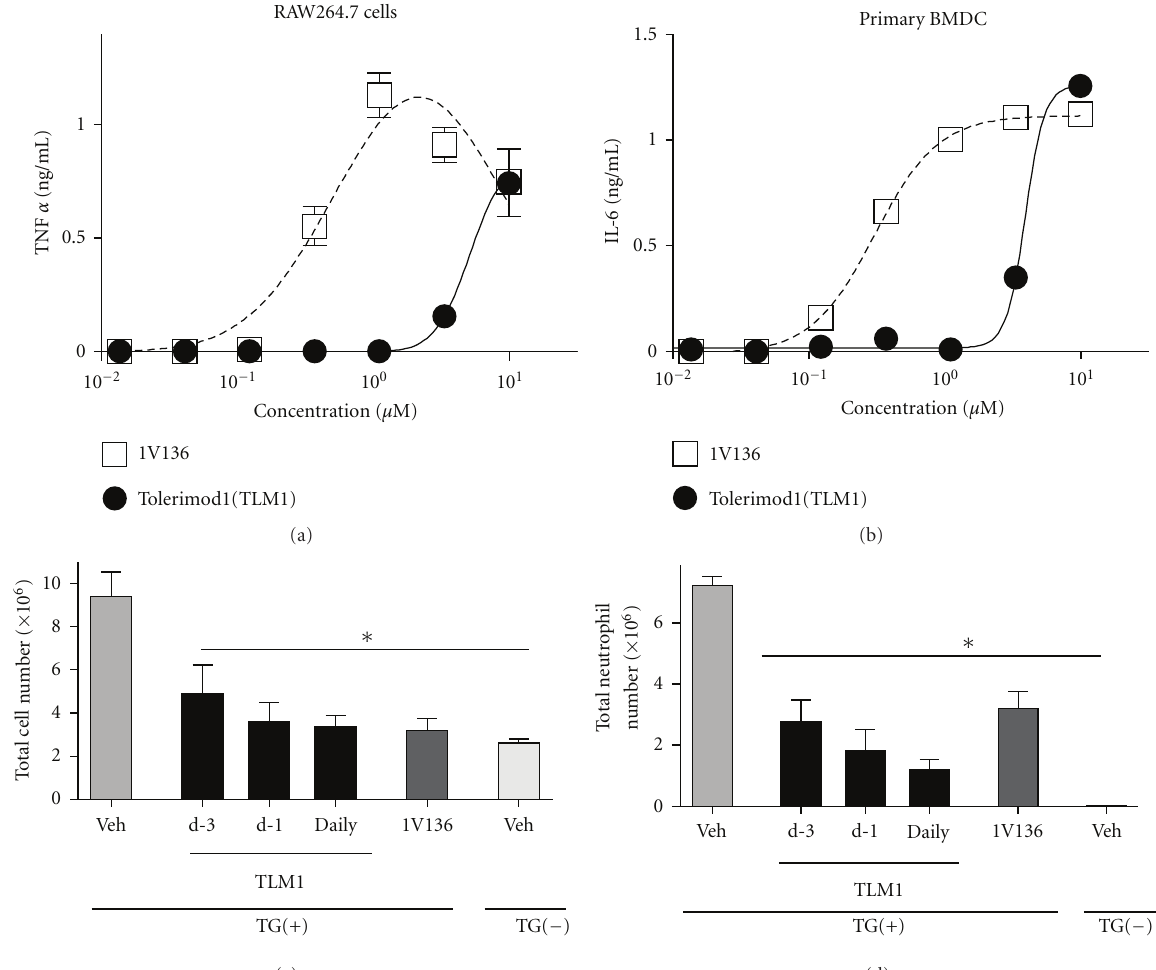
Figure 2: PEGylated TLR7 ligand reduced neutrophil recruitment in TG-elicited peritonitis. RAW264.7 (a) and primary BMDC (b) were treated 18 h with Tolerimod1 (TLM1), and TNF α and IL-6 in the supernatants were measured by ELISA. (c and d) WT mice ( n = 7 to 10 per group) were treated daily for three days (-3, -2, and -1) or one day (-3 or -1 day) of s.c. 200 nmol Tolerimod1 (TLM1). Peritonitis was induced on day 0. Total cell number (c) and total neutrophil number (d) recovered in the peritoneal lavage were measured. Data shown are mean ± SEM and are pooled 2 independent experiments that showed similar trends. ∗ Denotes P < 0 . 05 by one way ANOVA with Dunnett’s post hoc testing compared to the vehicle-treated